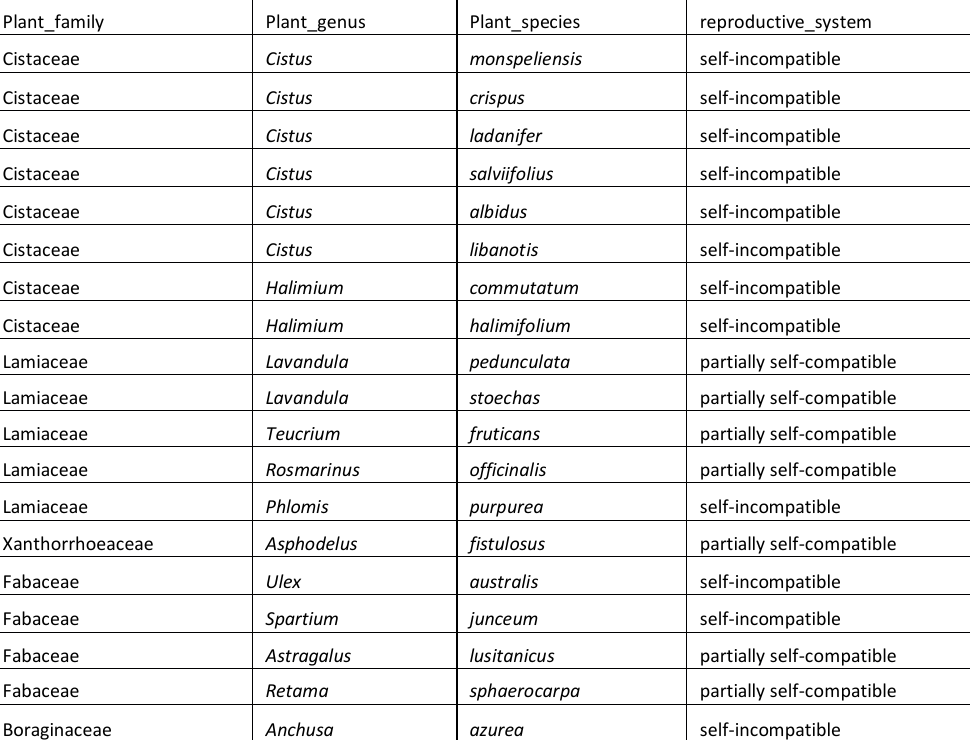
Table S4. List of plant species surveyed and their mating